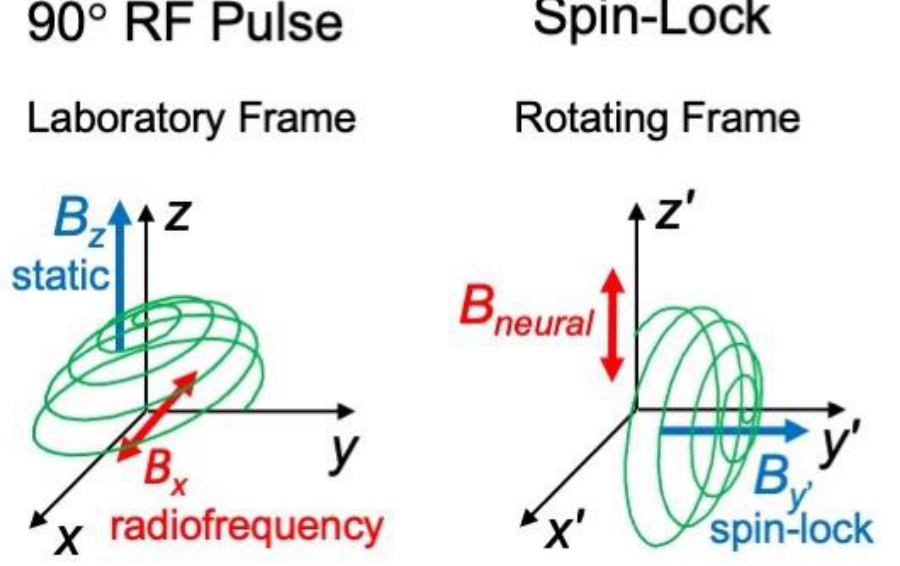
Figure 12. Comparison of a 90° radiofrequency pulse in a traditional MRI pulse sequence to a neural magnetic field in a spin-lock MRI pulse sequence. In the traditional experiment ( left ), the radiofrequency pulse rotates the spins from the direction of the static field ( z ) into the transverse ( x - y ) plane. In a spin-lock experiment ( right ), the neural magnetic field rotates the spins from the y ’ direction in the rotating frame into the x ’ - z ’ plane.